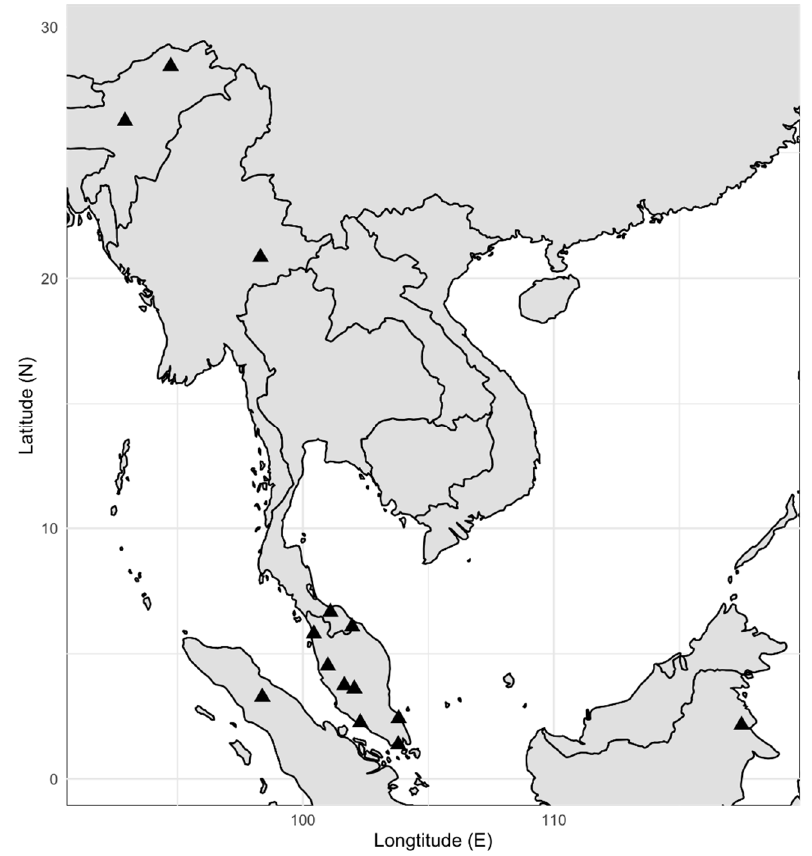
Figure 4. Distribution of Garcinia atroviridis .